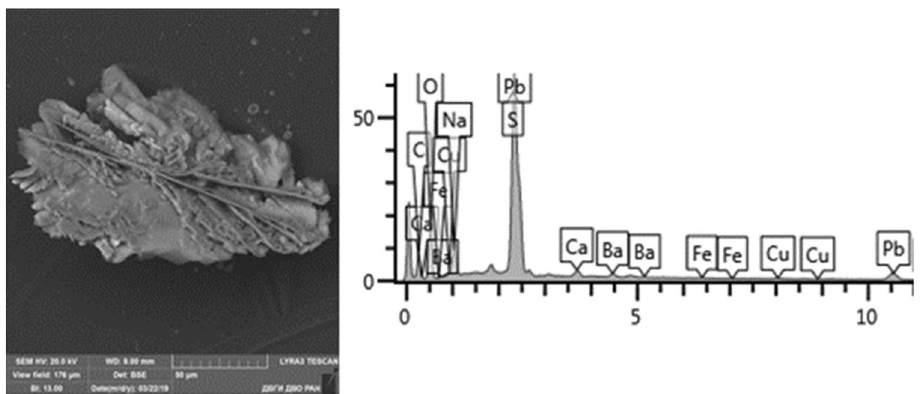
Figure 13. Nonferrous metals etching. Particles morphology. Scanning electronic microscopy. Measuring interval 50